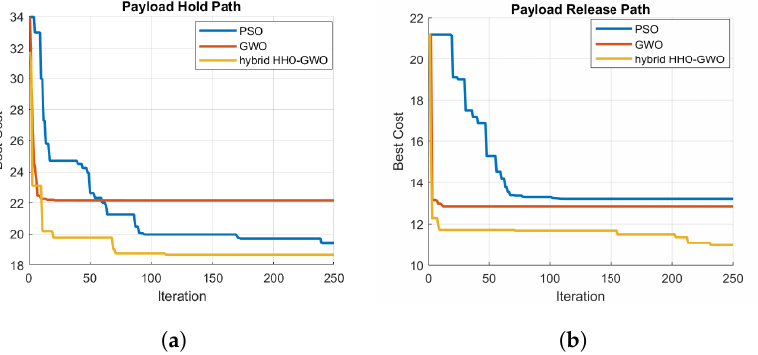
Figure 10. The optimized payload hold ( a ) and release ( b ) path performance of metaheuristic optimization algorithms for Map 3.